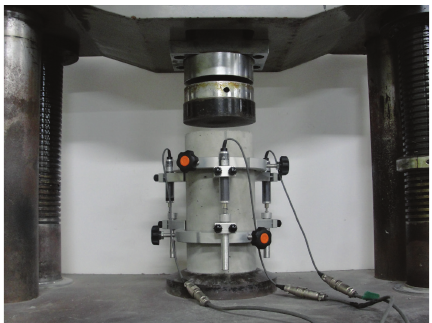
Figure 1: Testing setup and instrumentation for the uniaxial com- pressive test of a concrete